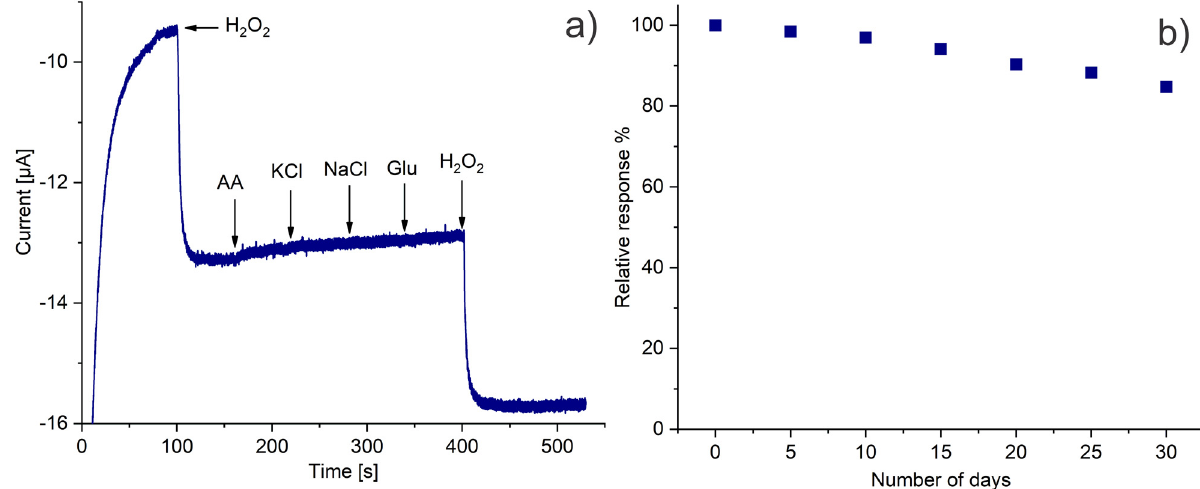
Figure 7: ( a ) Selectivity and ( b ) stability of the SPCE/PAni/AuNP/cMWCNT/CAT